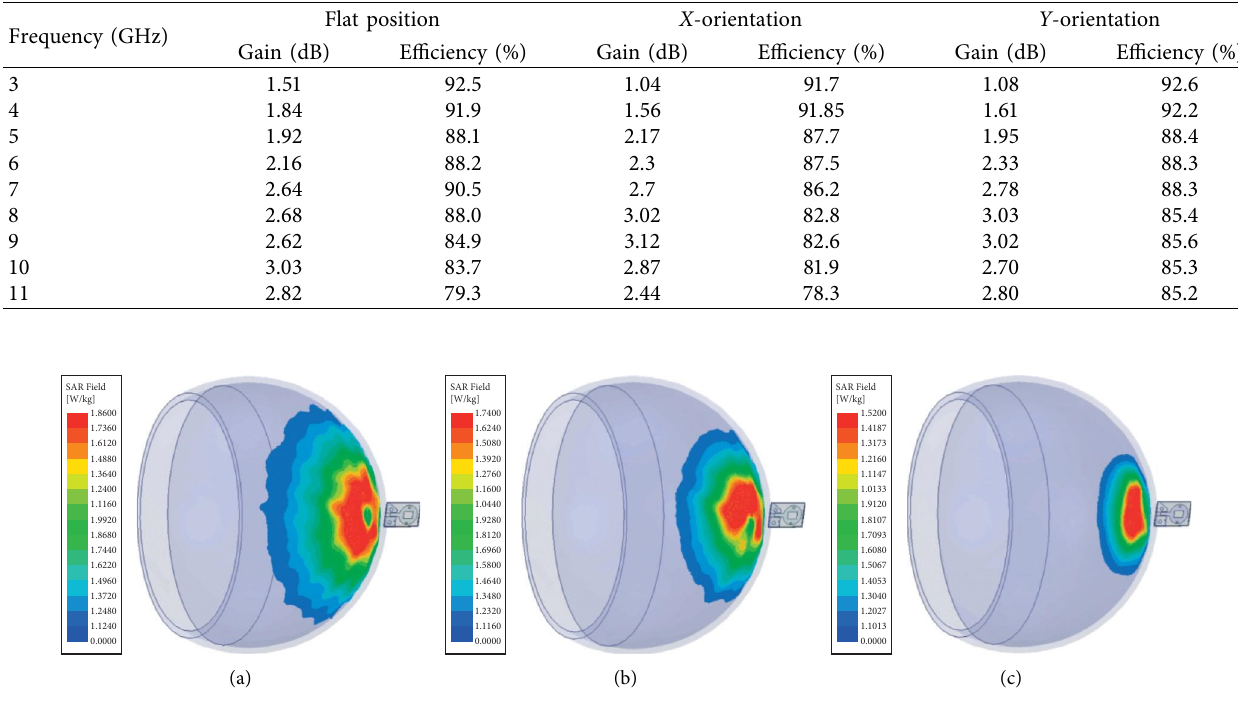
Table 3: Simulated gain and radiation efficiency of the antenna after structural deformation.